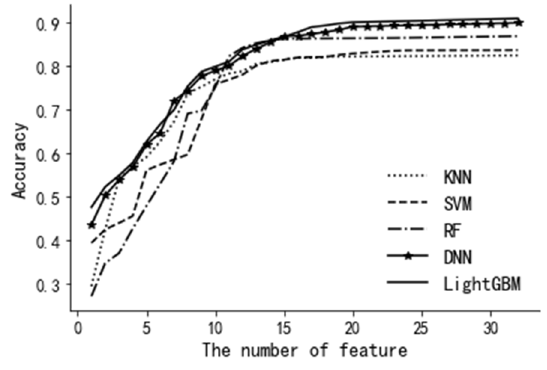
Figure 7. Comparison of model accuracy.